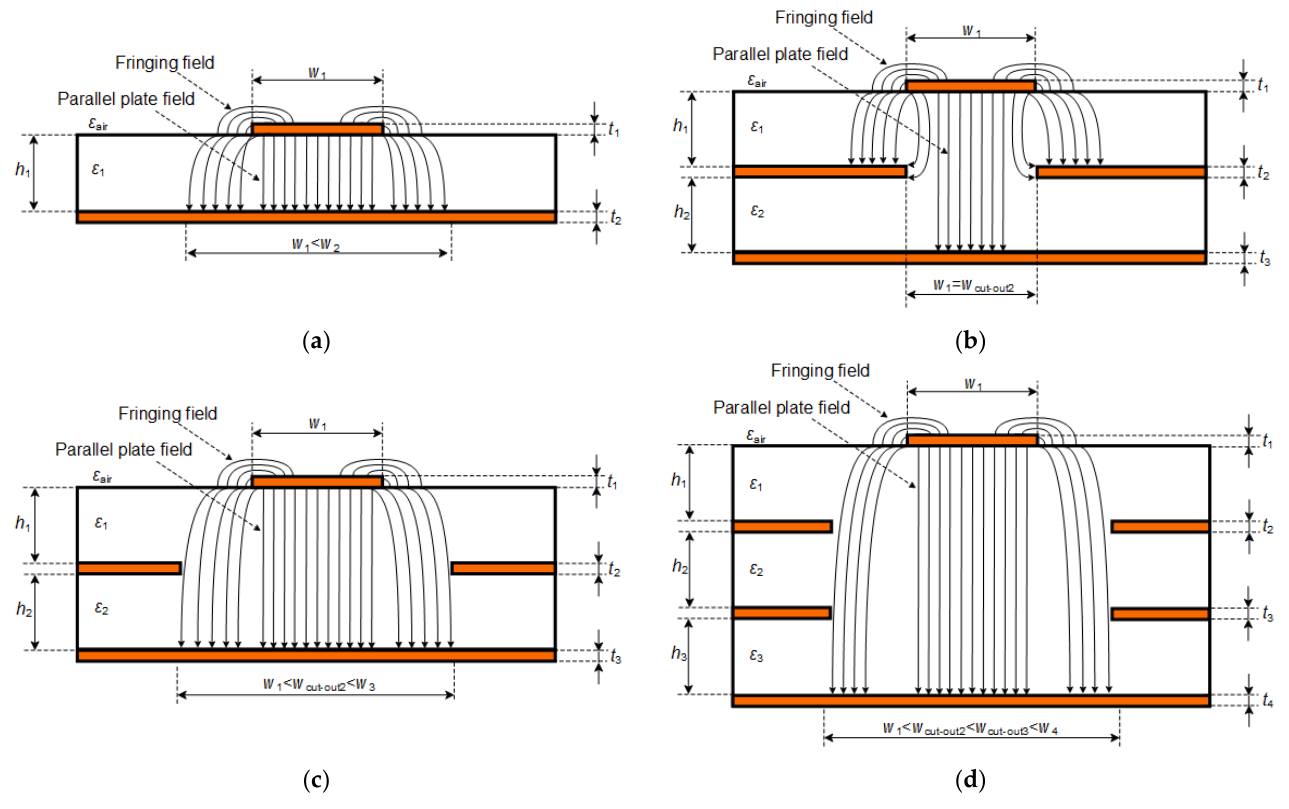
Figure 1. Microstrip line structures: ( a ) general; ( b ) with a cut-out whose width is equal to the width of the discontinuity pad; ( c ) with a cut-out whose width is much larger than the width of the discontinuity pad; ( d ) configuration with multiple cut-outs.